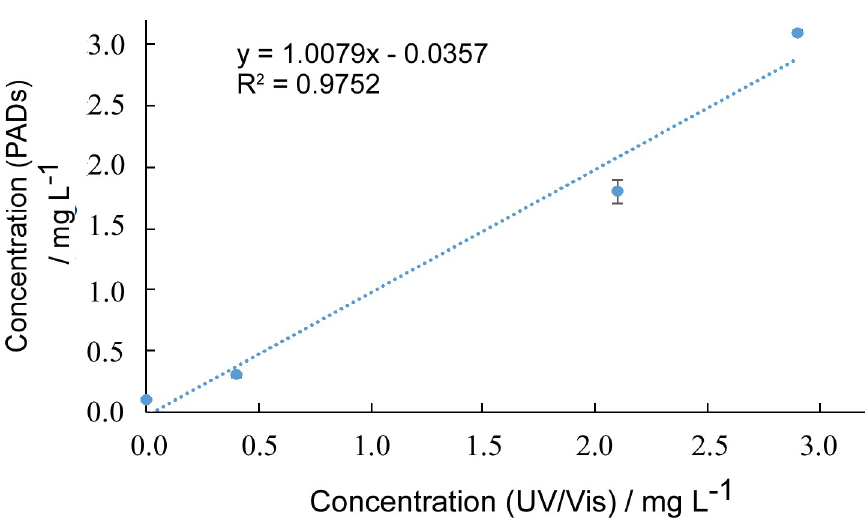
Fig 5. Comparison of PO43- levels in freshwater samples detected using UV/vis spectroscopy via PMB reaction (n = 3) and modified PMB method on the paper microfluidic device with flatbed scanner image capture (n = 6).